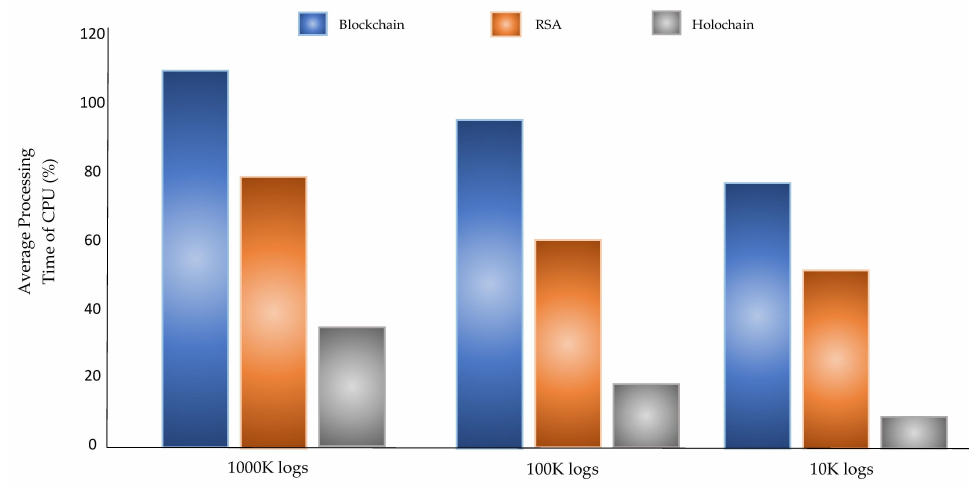
Figure 19. Log preservation performance in RSA, Blockchain, and